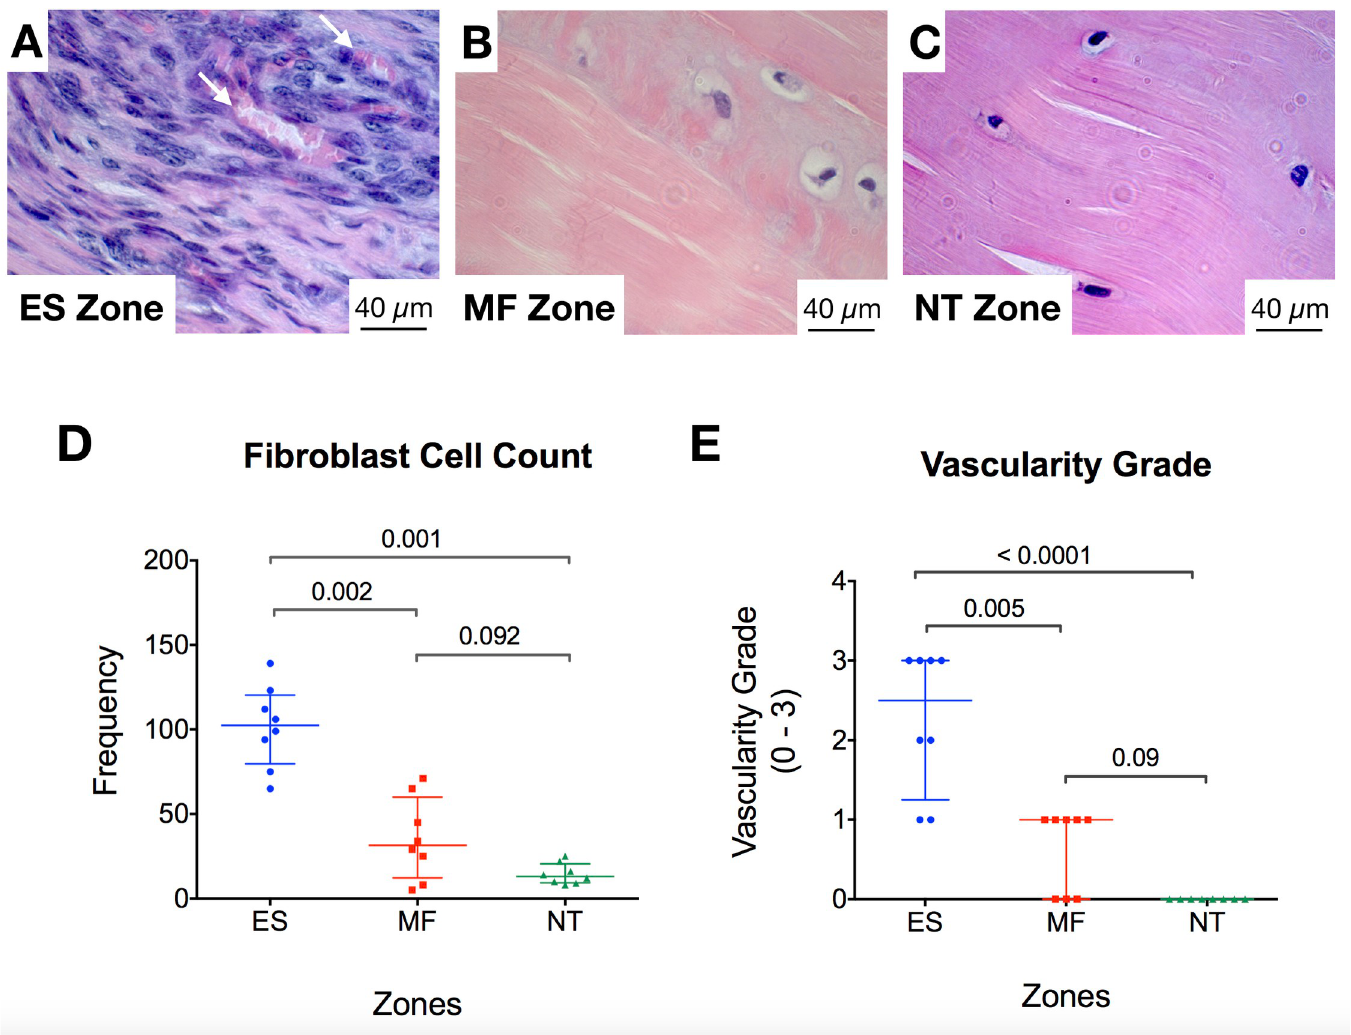
Fig 5. Cellularity and vascularity of ES suture implanted tendons. A-C) Bright field microscopy images showing the ES (electrospun) zone in A, the MF (monofilament control) zone in B, and the NT (normal tendon) zone in C. Note the high concentration of proliferative fibroblasts and the blood vessels (white arrows) seen in A. Also note similar appearance of scant well-orientated fibroblasts and no blood vessels in MF and NT zones. D) Graph showing median fibroblast cell count in ES, MF, and NT zones. E) Graph showing median vascularity grade in ES, MF, and NT zones. P values (Mann Whitney U test) are indicated to show the level of significance between